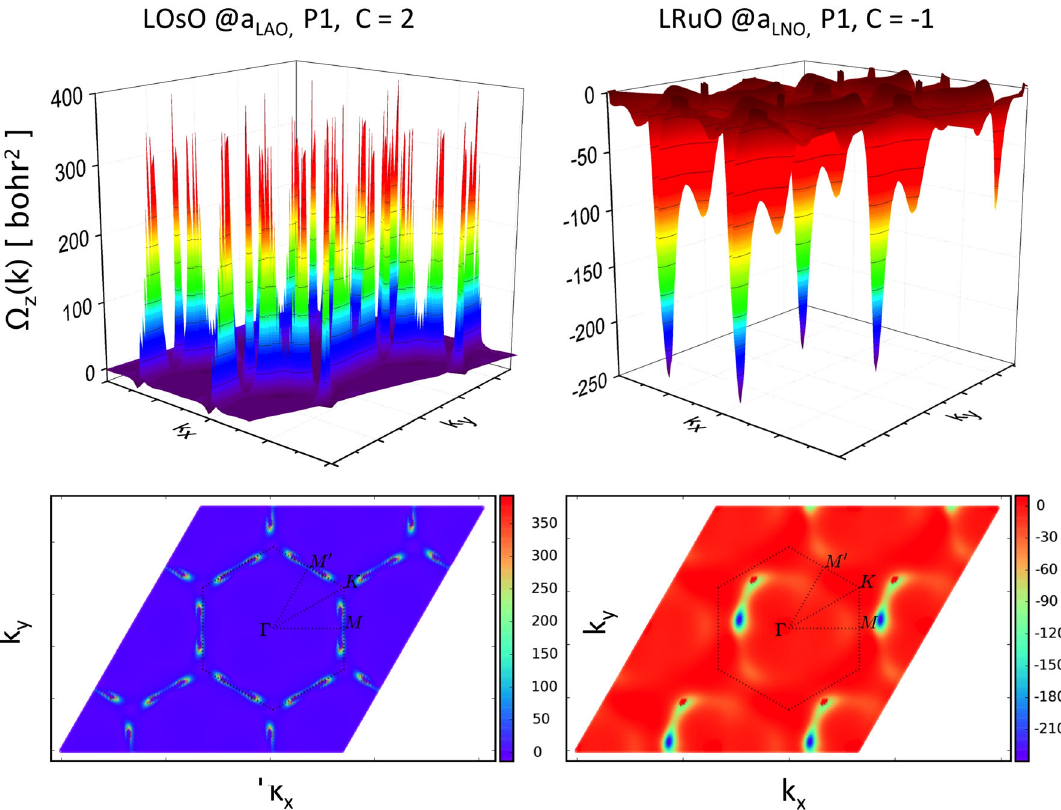
! Þ of (upper) 2LOsO ( C = 2) and (lower) 2LRuO ( C = − 1).